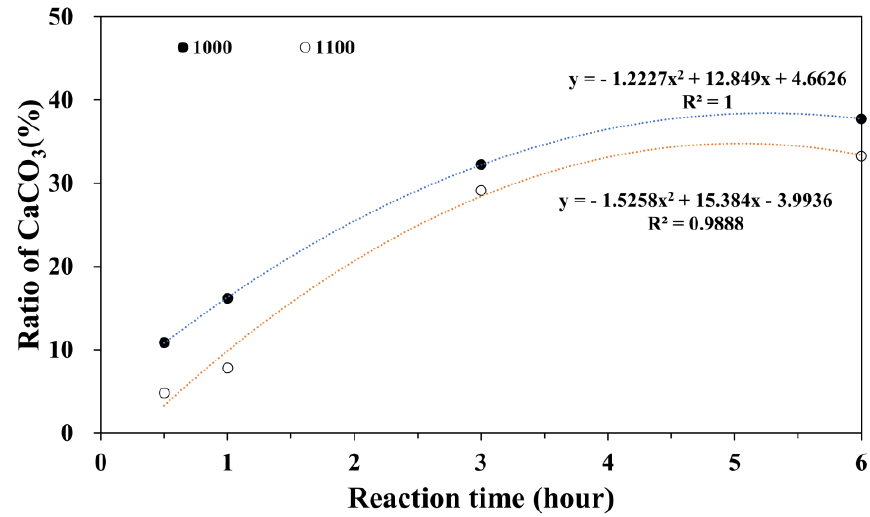
Figure 4. Calcite generation based on reaction time.